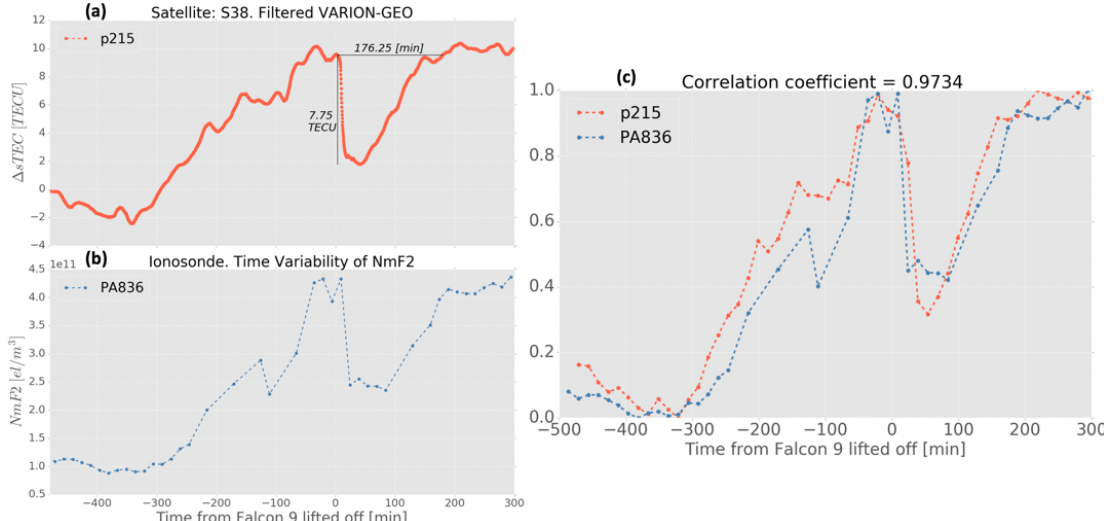
Figure 5. ( a ) The VARION-GEO ∆ sTEC solutions obtained from station p215, satellite S38; ( b ) the NmF2 time variability obtained from ionosonde PA836; and ( c ) the down-sampled and normalized ∆ sTEC solutions ( red curve ) and the normalized NmF2 time series ( blue curve ) plotted using a common scale [0, 1]. This figure shows a high correlation between the VARION-GEO ∆ sTEC solutions and ionosonde data. The correlation coefficient between the two curves is